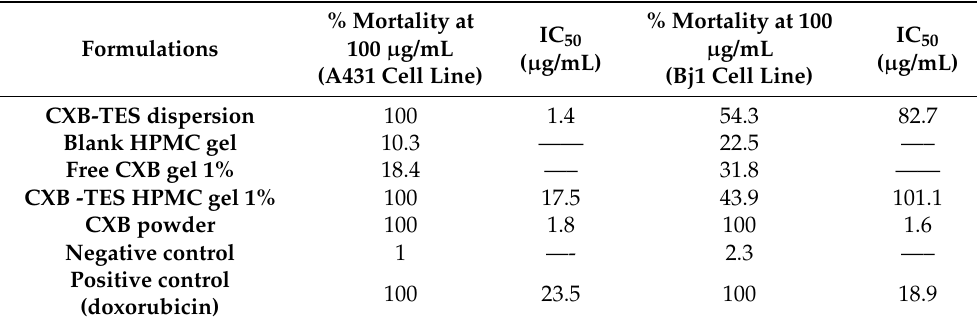
Table 5. Cytotoxicity effect of the different tested formulations at 100 µ g/mL on A431 and Bj1 cell lines and IC 50 for active